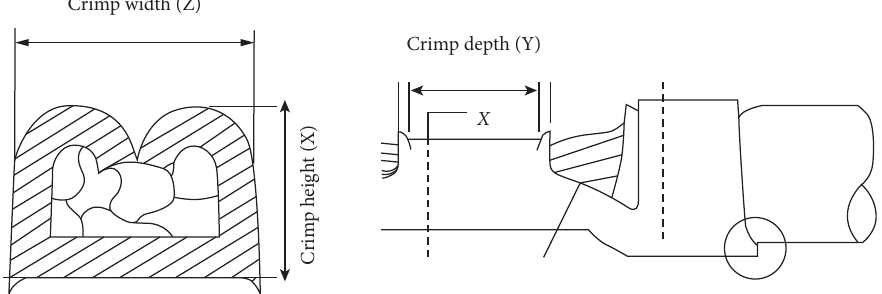
Figure 1: Crimp dimension measurement.